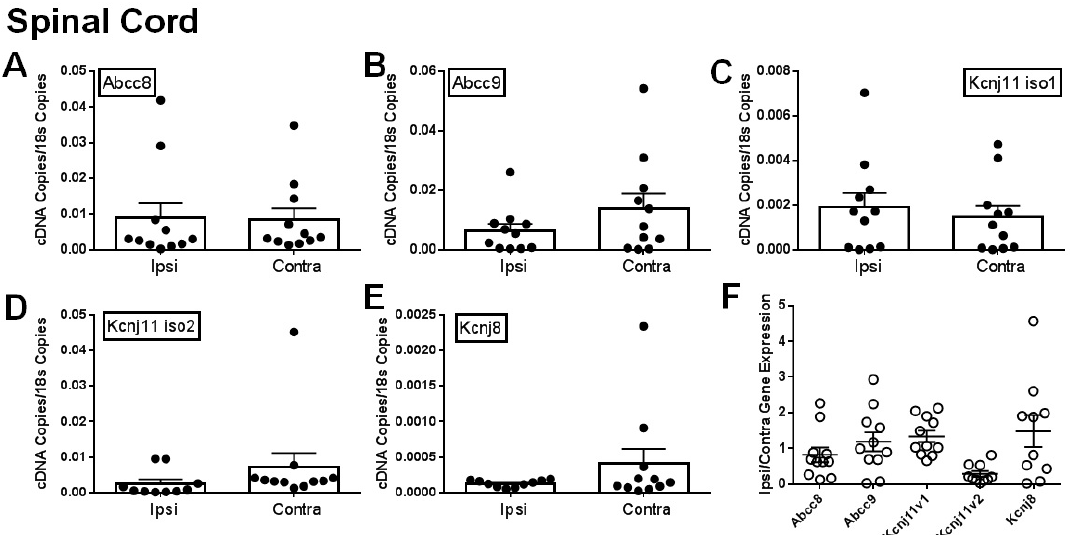
Figure 3. Expression of K ATP channel subunits in spinal cord are decreased after spinal nerve ligation (SNL). Relative expression of K ATP channel subunits in ipsilateral (Ipsi) and contralateral (Contra) spinal cords 30 days post SNL. Relative gene expression for Abcc8 (protein: SUR1, A ), Abcc9 (protein: SUR2, B ), Kcnj11 iso1 (protein: Kir6.2, C ), Kcnj11 iso2 (protein: Kir6.2, D ) and Kcnj8 (protein: Kir6.1, E ) compared against matching tissue expression for 18s . * p < 0.05 comparison between Ipsi vs. Contra . ( F ). Data in A-D are expressed as mean fold change (Ipsi/Contra) between matching samples.